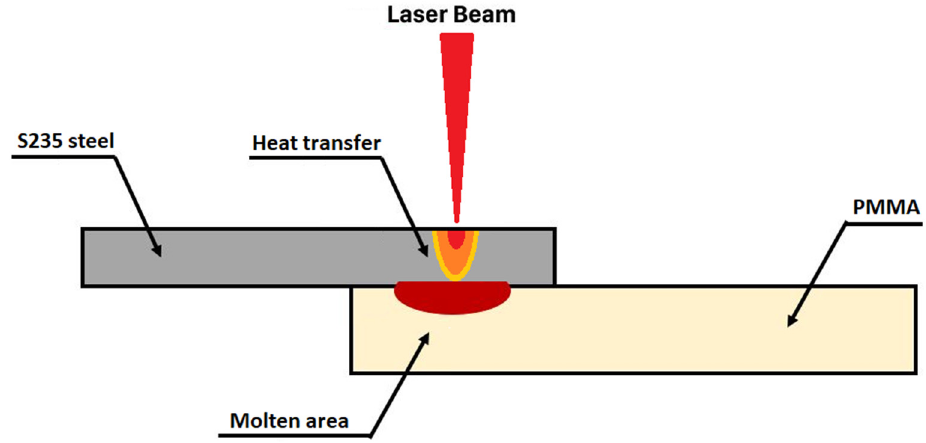
Figure 2. Schematics of the laser direct joining technique through heat conduction.